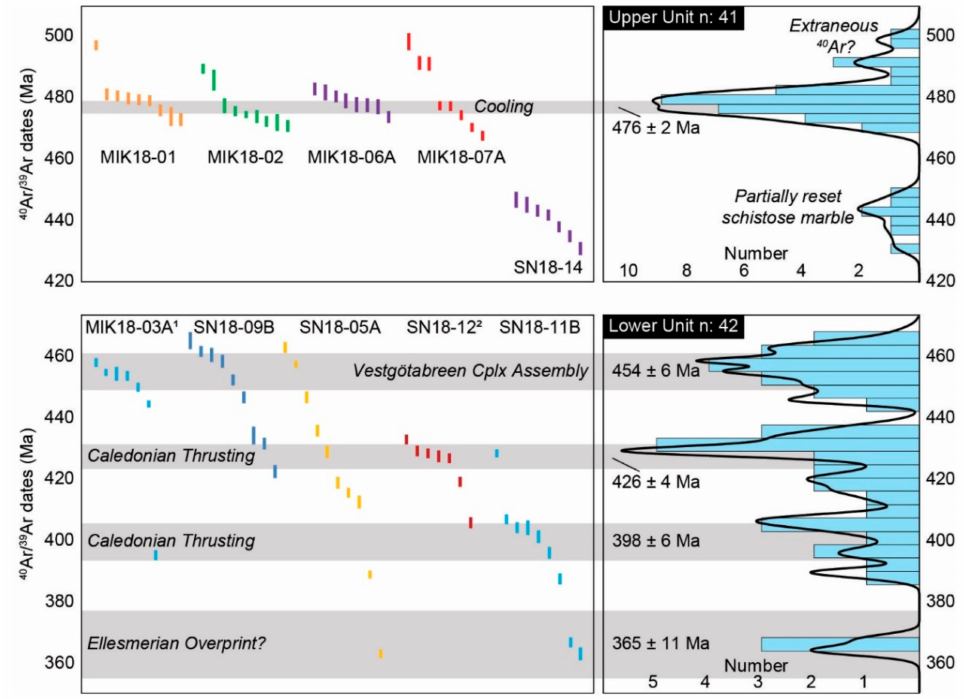
Figure 4. Results of in situ white mica 40 Ar / 39 Ar geochronology from the Upper Unit ( top ) and the Lower Unit ( bottom ). The left diagrams show the individual dates ( ± 1 σ uncertainty) organized from oldest to youngest. The right side depicts histograms of the samples with corresponding relative frequency curves. The populations were derived by Gaussian deconvolution of each entire sample dataset. The grey bars represent the uncertainty of each population that has been attributed geological significance. Interpretations of each population are presented within the grey